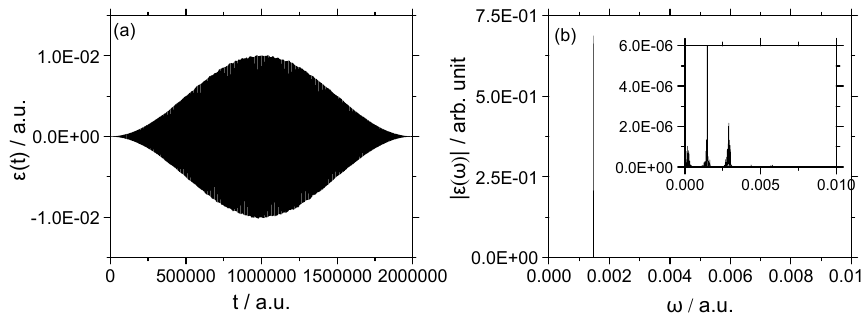
Figure 8. ( a ) The optimal field ε ( t ) obtained with the initial guess, Equation (21), for the vibrational–rotational excitation, ( v = 0, J = 0) → ( v = 1, J = 2), in the strong-field regime; ( b ) the spectrum of ε ( t ).